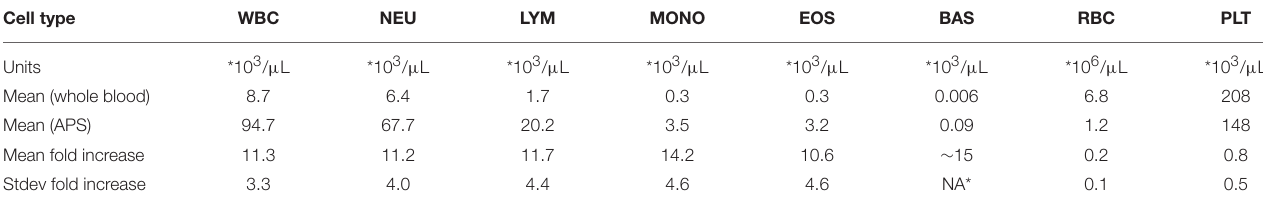
TABLE 1 | Cellular composition of the whole blood and APS.